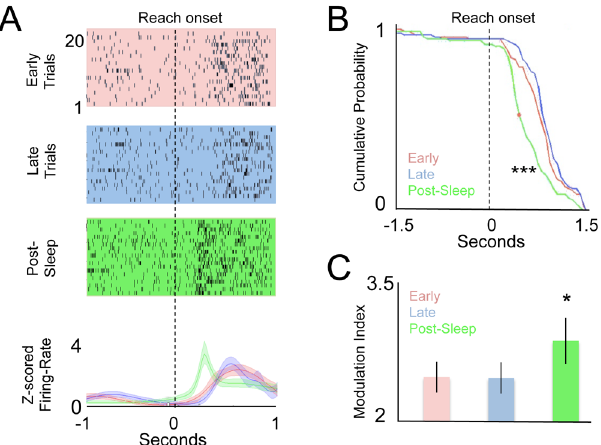
Fig 3. Comparison of online and offline changes in neural activation. (A) Change in movement-related activation of a single neuron during Reach 1early , Reach 1late , and Reach 2early . Dotted line is the time of reach onset. Traces below represent a Bayesian adaptive regression spline fit of the respective PETH. (B) Curves show respective cumulative distributions of the single neuron PETH time to peak (red dot represents median timing). While there was not a significant change in the distribution for online learning (Kolmogorov-Smirnoff test, p = 0.9 comparing Reach 1early versus Reach 1late , there was a significant shift after sleep ( p < 0.001 comparing Reach 2early to both Reach 1early and Reach 1late, n = 4 animals, 99 units). (C) Change in task-related neural modulation. Task related modulation index is ratio of baseline firing to the peak instantaneous firing rate n = 4 animals, 99 units). Error bars show standard error of the mean (S.E.M.) * p < 0.05, *** p <